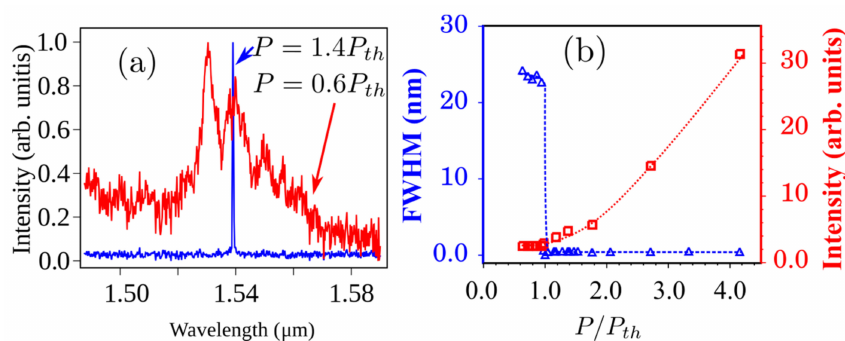
Figure 2. ( a ) Emitted spectrum of Er-RFL before (red) and after (blue) the laser threshold; ( b ) Emitted intensity (squares) and FWHM (triangles) of the Er-RFL system as a function of the normalized input power. The measured threshold power was P th = 16.30 ± 0.05 mW. The dotted lines are a guide to the eyes. (Reproduced with permission from ref.